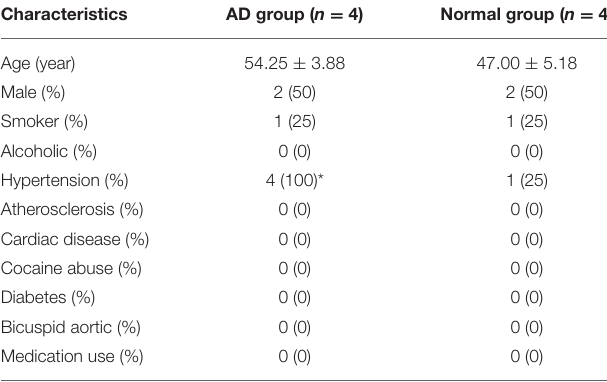
TABLE 1 | Clinical characteristics of the AD and normal